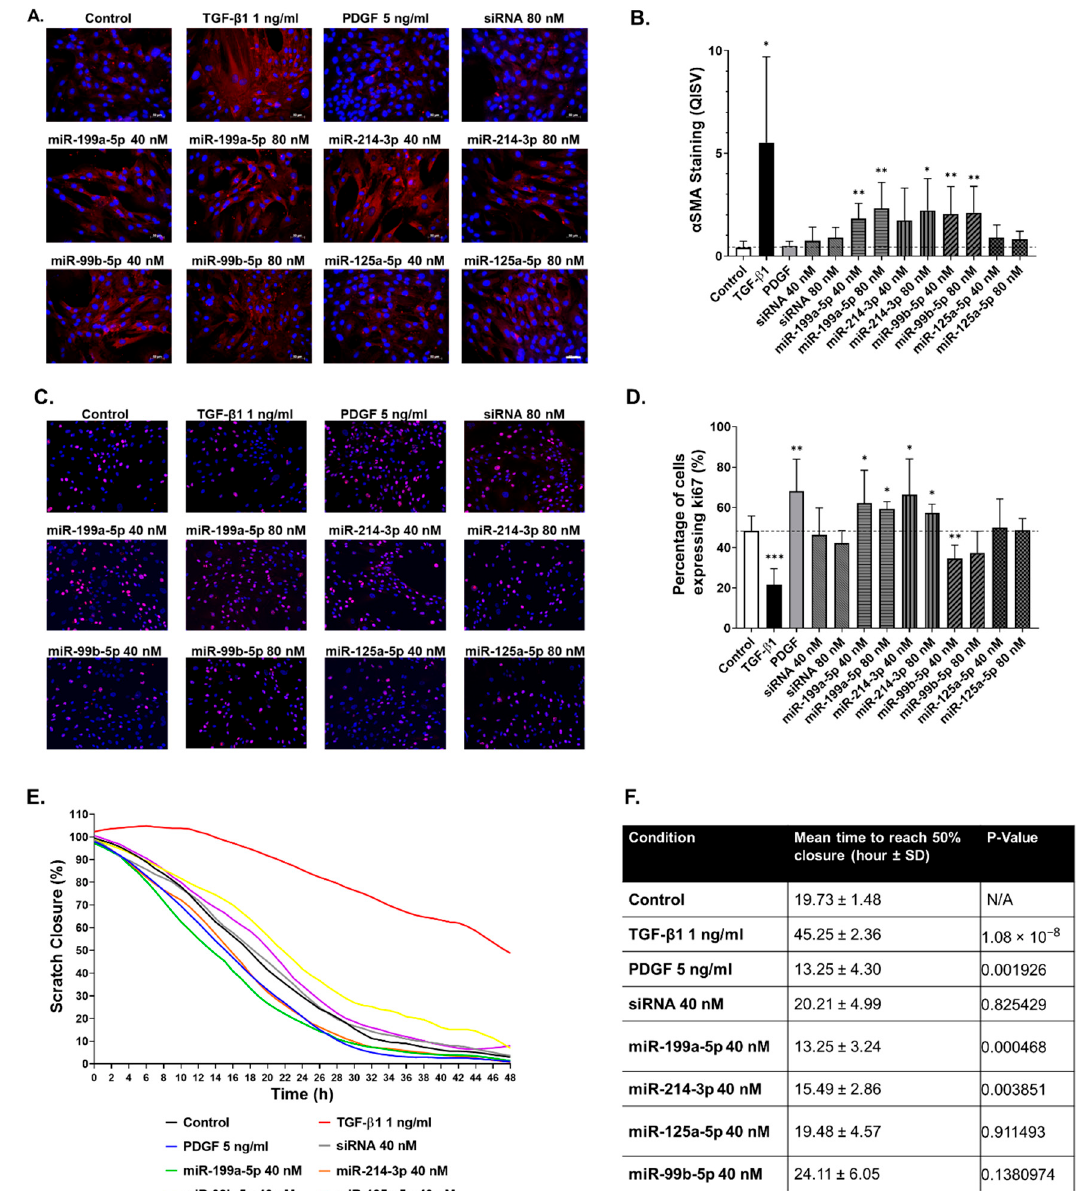
Figure 7. miR-199a-5p, miR-214-3p and miR-99b-5p promote hTERT-HSC activation. hTERT-HSC were transfected with the four mimics and an siRNA negative control (40 and 80 nM) for 72 h and were either fixed or used for migration assessment. α SMA staining was carried out to investigate the potential of the 4 miRNA mimics to elicit HSC activation, which were compared to positive controls TGF- β 1 and PDGF ( A ) and quantified using ImageJ ( B ). Proliferation was assessed using ki67 staining ( C ), and was also quantified using ImageJ ( D ). Migration was assessed using a migration assay that was imaged every hour over 48 h and quantified using ImageJ to assess the speed of wound closure ( E ). The time for each condition to reach 50% wound closure was assessed to calculate significance between migration capacities for each condition ( F ). n = 6 for immunostaining quantification. n = 8–9 for the migration assay. Student’s unpaired t test; *, p ≤ 0.05; **, p ≤ 0.01; ***, p ≤ 0.001.